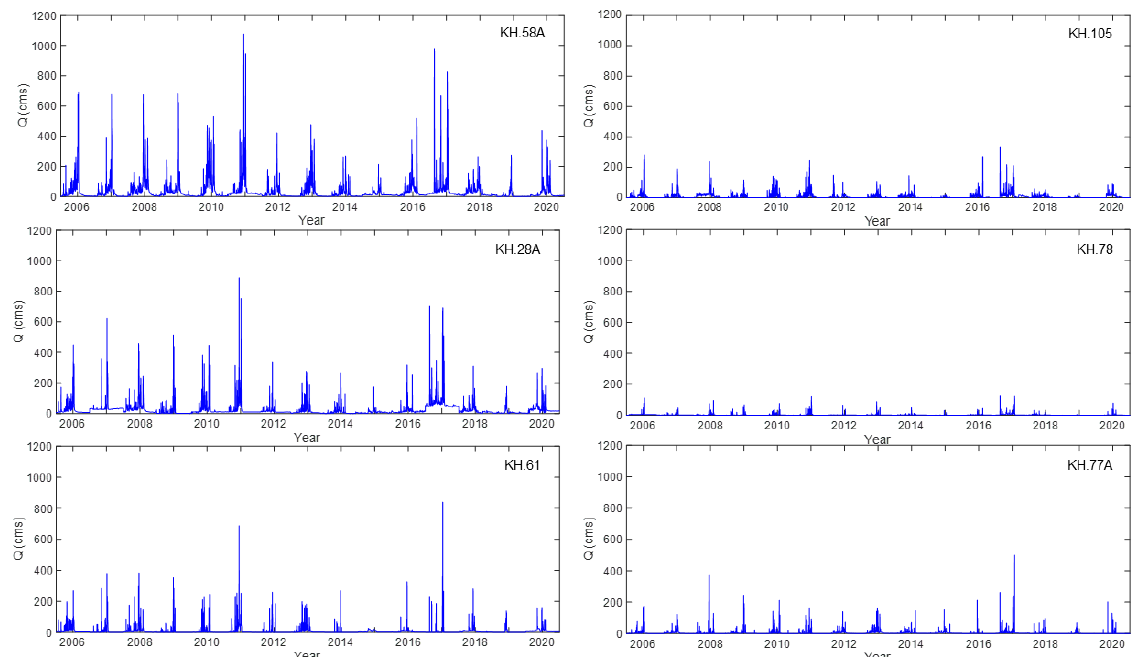
Figure 4. Discharge data collected from stations located in the Loei river basin.